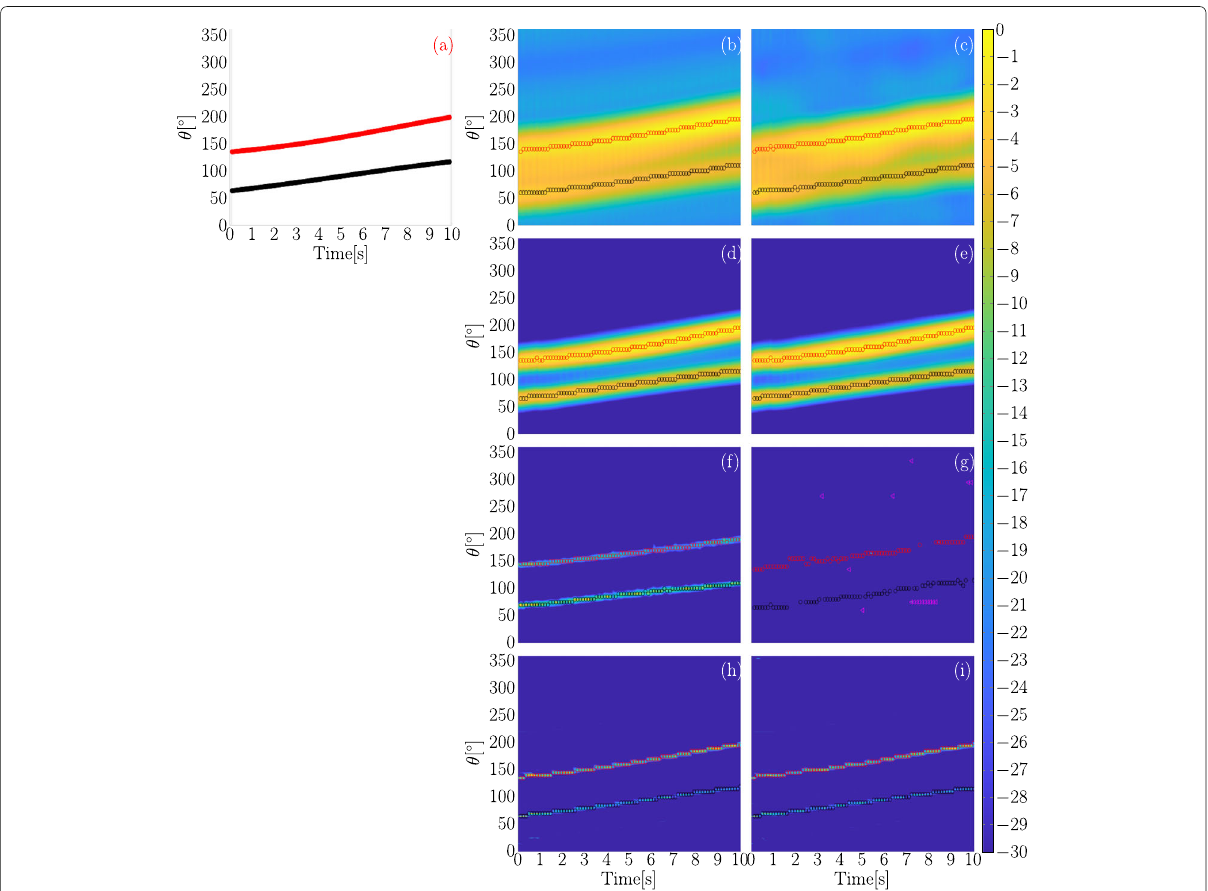
Fig. 7 Estimation results for the first virtual room setup. For the CBF, MVDR ,and SRP-PHAT methods, the estimation results are shown using the spatial spectrum of all frames. For the proposed SAVE-MSBL-EM method, the estimation results are shown using the weights w of all frames. a The trajectories of two source. b Estimation result of CBF method in free field. c Estimation result of CBF method in low reverberation. d Estimation result of SRP-PHAT method in free field. e Estimation result of SRP-PHAT method in low reverberation. f Estimation result of MVDR method in free field. g Estimation result of MVDR method in low reverberation. h Estimation result of the proposed SAVE-MSBL-EM method in free field. i Estimation result